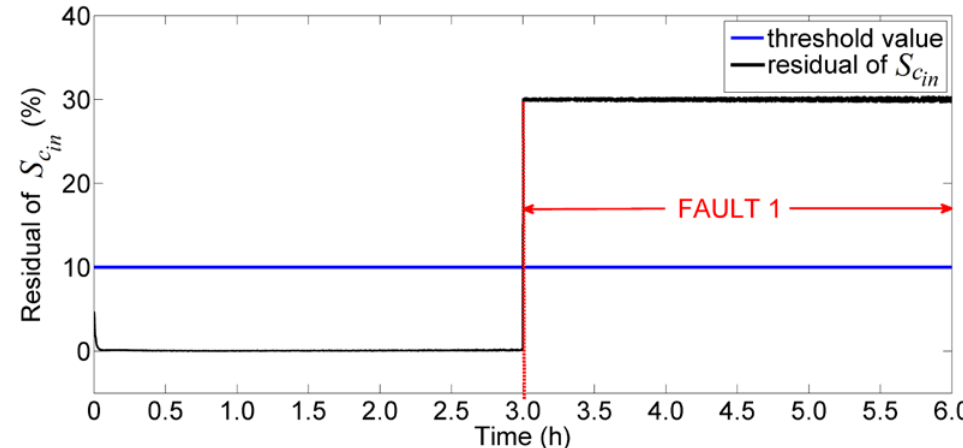
S for faulty scenario 1. for faulty scenario in in c